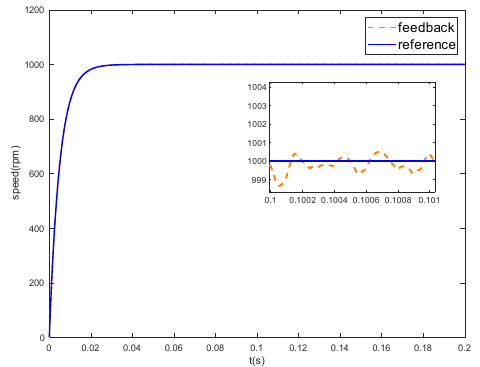
Figure 11. Speed response curve when α = 0.005.